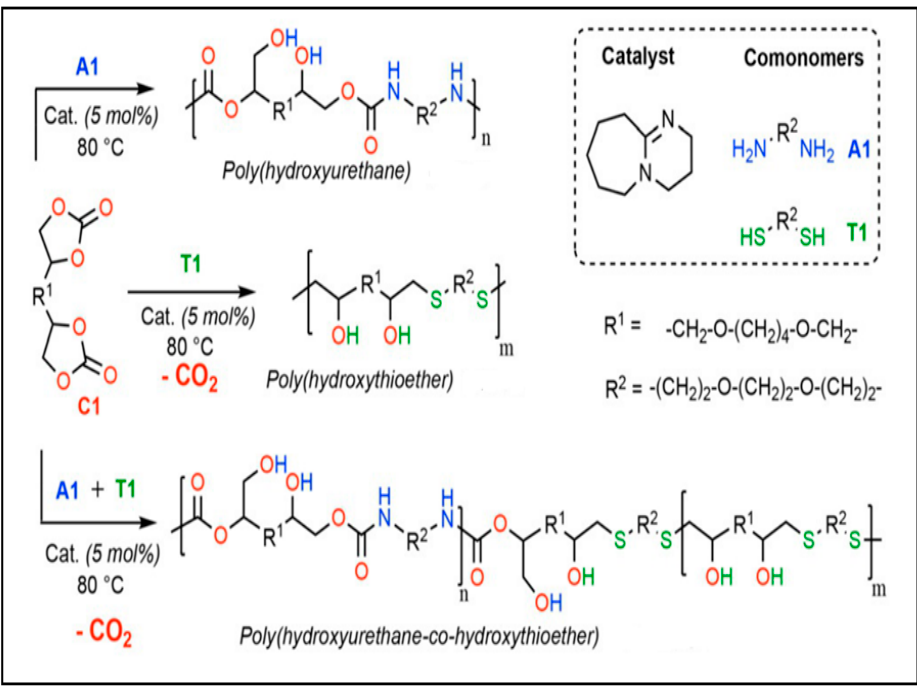
Figure 5. S-alkylation used to obtain NIPU foams. Reprinted from ref [48] with permission from the publisher.